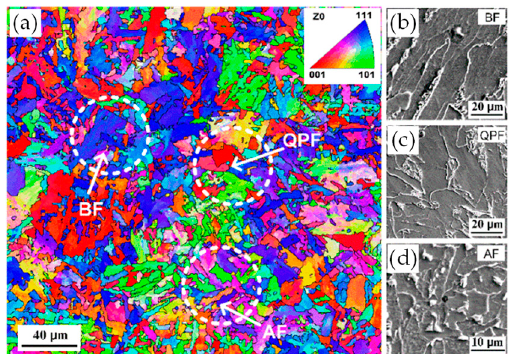
Figure 13. ( a ) Electron backscattered diffraction (EBSD) inverse pole figure (IPF) map and ( b – d ) corresponding SEM micrographs of different constituents of the TC# steel sample subjected to 43% deformation and 5 °C/s cooling.